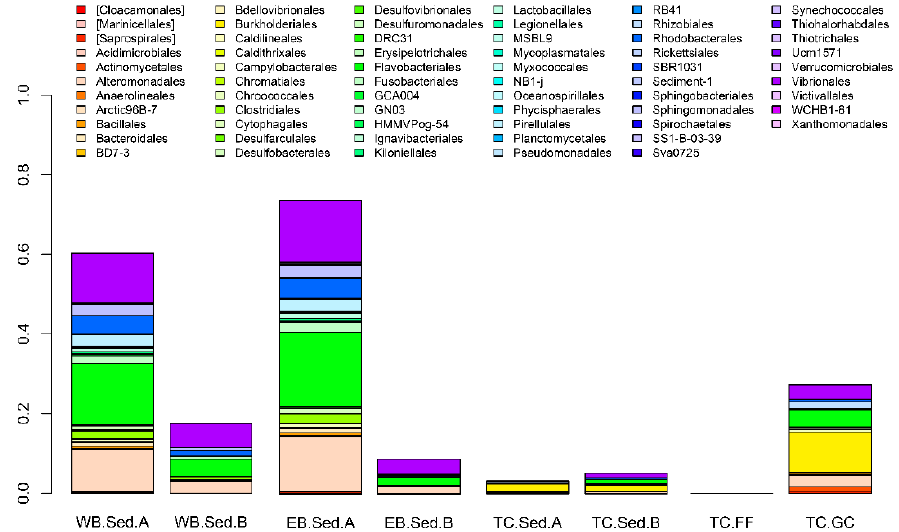
Fig. 3: Sample site bacterial community organized by bacterial Orders and represented as the relative abundance excluding unidentified taxa. Note: Tidal Creek fecal flush (TC FF) was composed of almost all unidentified taxa. TC-Tidal Creek; EB- East Beach; WB- West Beach; GC- Gut Content